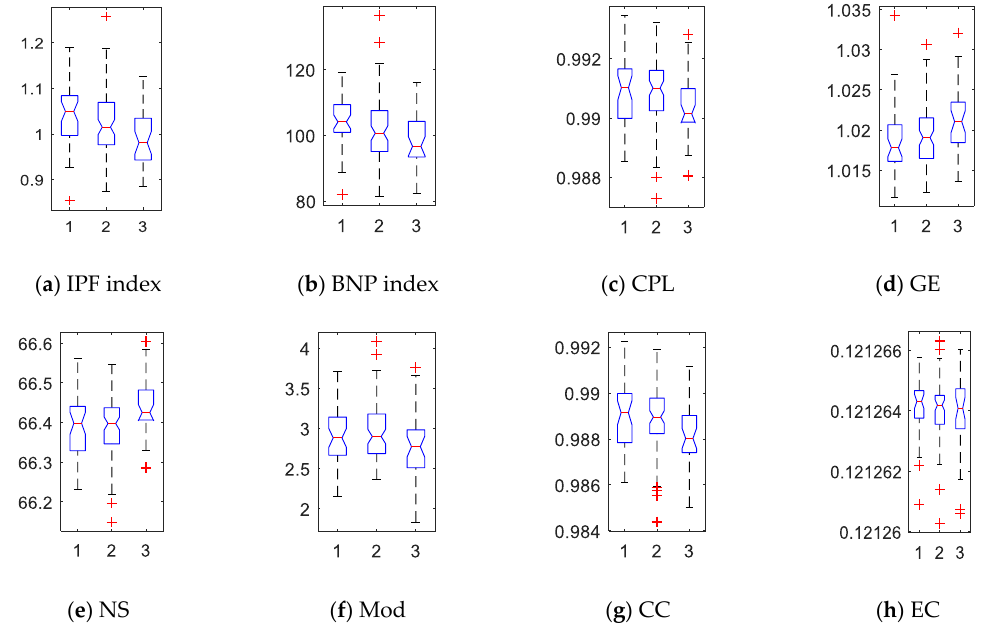
Figure 4. Box plots of network indices for 150 subjects across the three groups. Here, 1, 2, and 3 represent AD, MCI, and NC, respectively. Network indices: ( a ) IPF—integrated persistent feature; ( b ) BNP—Betti number plot; ( c ) CPL—characteristic path length; ( d ) GE — global efficiency; ( e ) NS—nodal strength;